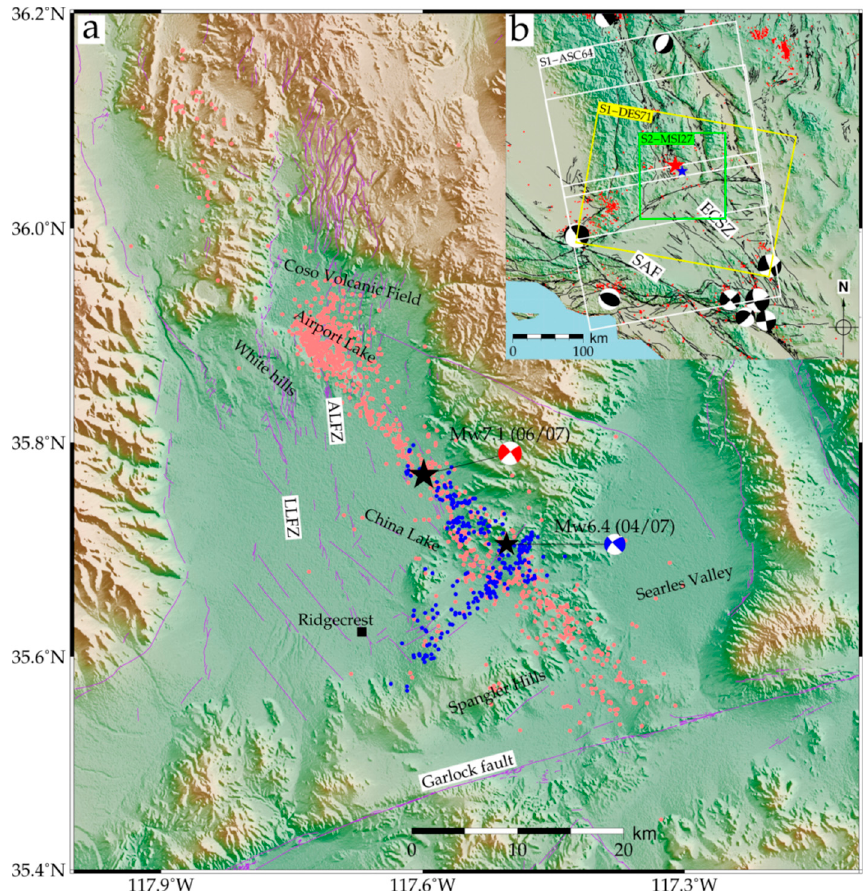
Figure 1. Tectonic setting of the 2019 Ridgecrest earthquake sequence. ( a ) Spatio-temporal distribution of foreshocks and aftershocks. Two stars and beach balls mark the epicenters and focal mechanisms of the 2019 Mw7.1 Ridgecrest earthquake and the Mw6.4 Searles Valley earthquake (from the U.S. Geological Survey (USGS)), respectively. Blue and pink dots represent the spatial distribution and temporal evolution of foreshocks and aftershocks of the Mw7.1 mainshock, respectively. ( b ) White rectangle shows the spatial coverage of the Sentinel-1 ascending (track 64) data utilized in this study and the yellow one shows the spatial coverage of the Sentinel-1 descending (track 71) data. The green rectangle shows the spatial coverage of the Sentinel-2 optical image. Black moment tensors represent focal mechanisms of large historical events (Mw > 6.5) that occurred within southern California. ALFZ: Airport Lake fault zone; LLFZ: Little Lake fault zone; ECSZ: Eastern California shear zone; SAF: the Sande Andres fault.